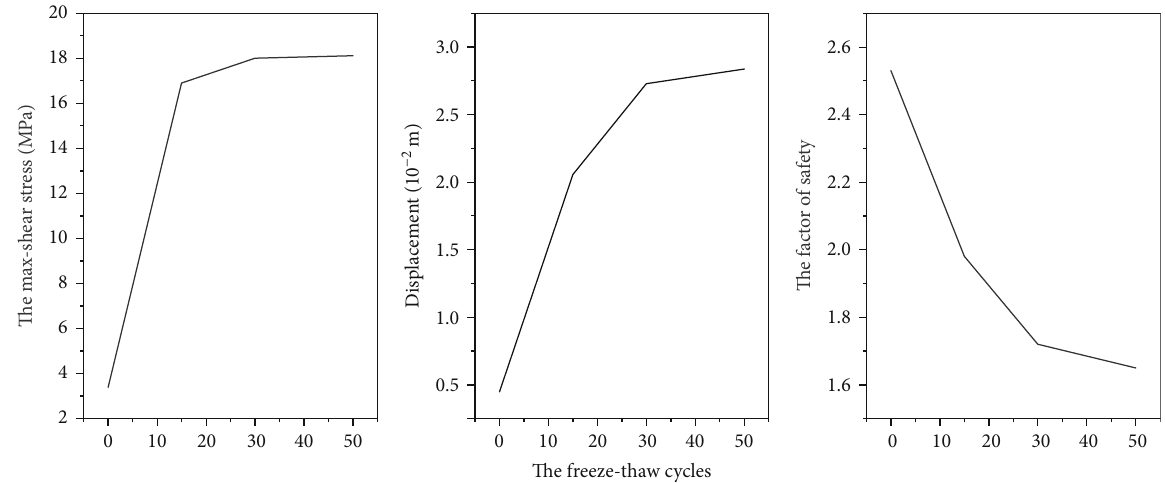
Figure 5: The mechanic features of the typical rocky slope under di ff erent FTC.